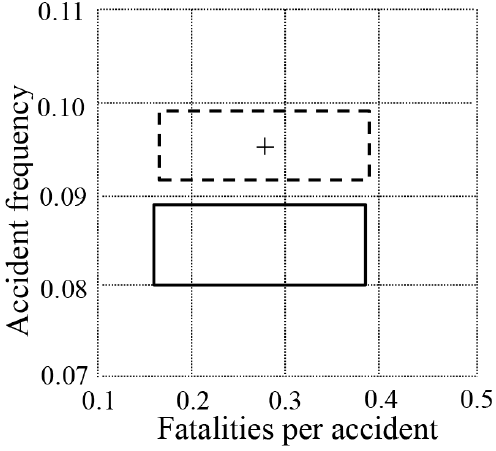
Figure 3. The risk matrix of the vessel traffic risk.